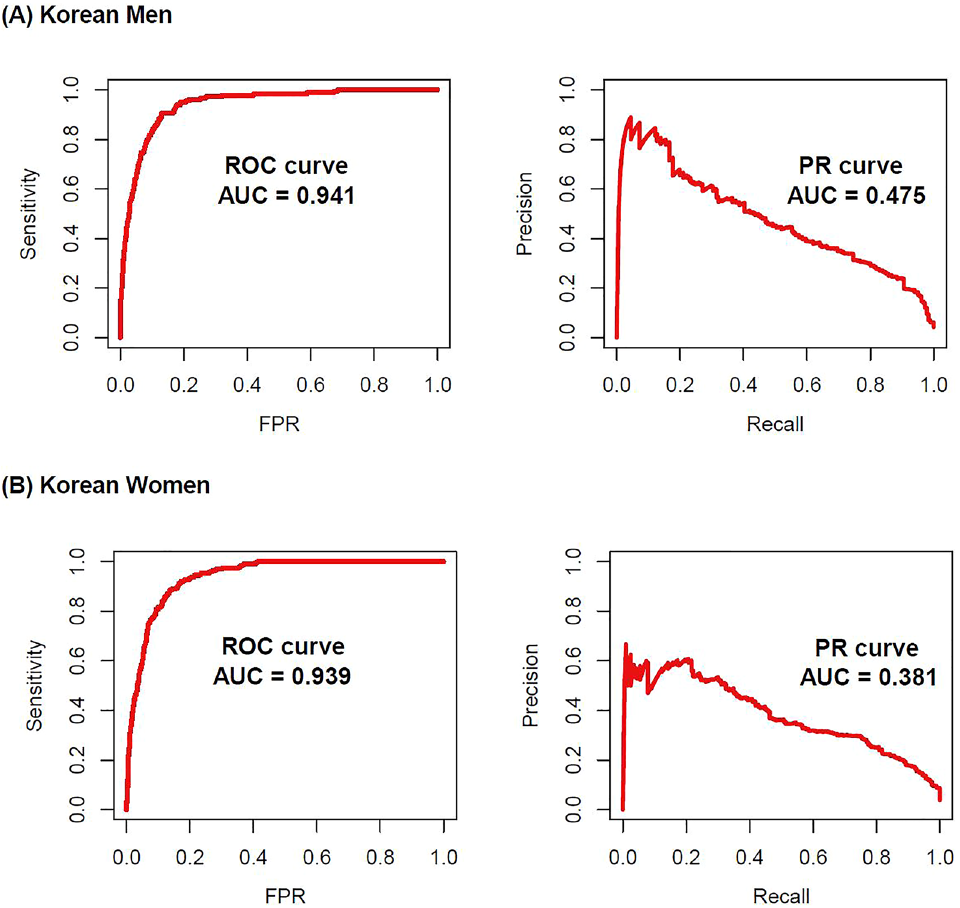
Figure 1. ROC and PR curves for the present gender-specific diabetes prediction model using the KNHANES dataset from 2017 to 2018. ( A ) Men ( B ) women. KNHANES Korea National Health and Nutrition Examination Survey, ROC receiver operating characteristic, AUC area under the curve, PR precision recall, FPR false positive